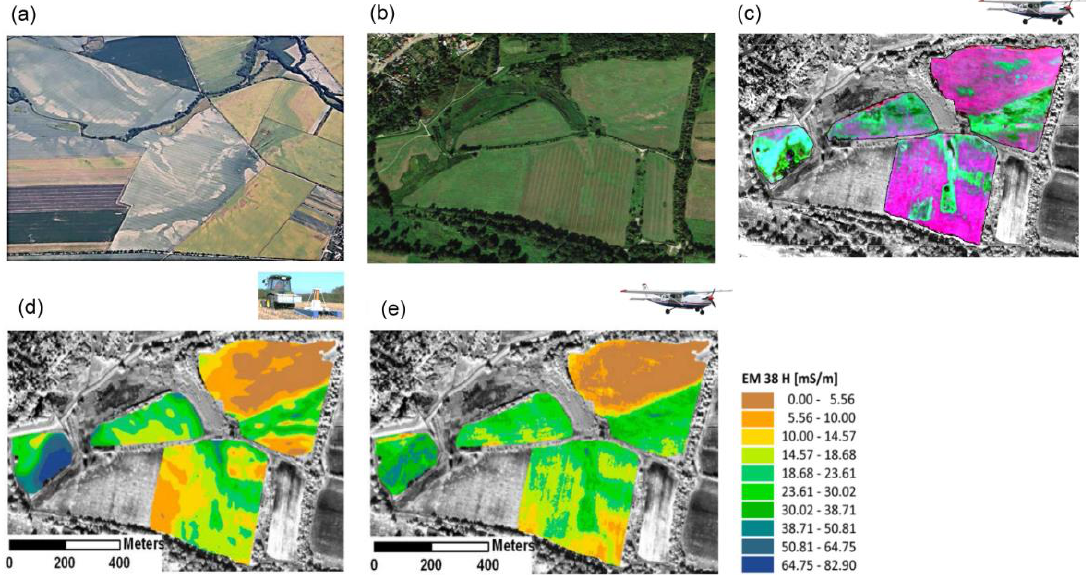
Figure 8. Soil moisture patterns – optical RS. ( a ) Vegetation patterns as a proxy for soil conditions and soil characteristics, photographs taken near Koethen-Wulfen, ( b ) study area “Rosslauer Oberluch”, Germany, ( c ) color Infrared image (CIR) taken from the hyperspectral sensor AISA-EAGLE / HAWK (DUAL), 0.40–2.5 µ m spectral resolution, 2 m ground resolution, 461 spectral bands, date of recording